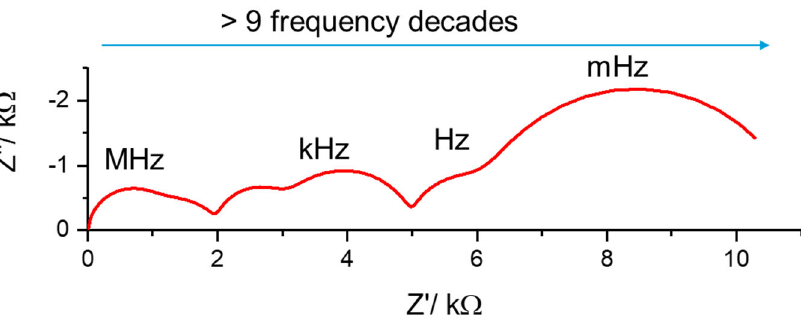
Figure 1. Idealized Nyquist EIS plot showing the extensive range of frequencies in which the various phenomena present in the steel–concrete system can be observed.